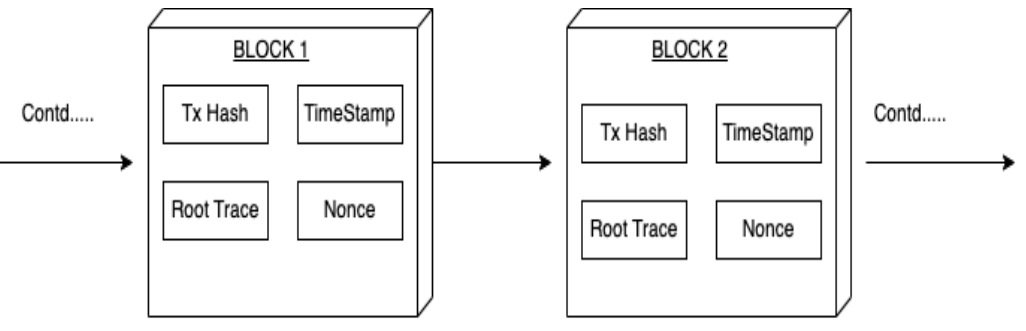
Figure 4. Blockchain architecture .